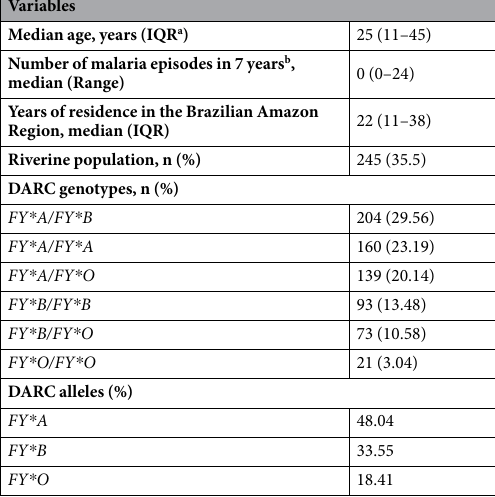
Table 1. Demographic, epidemiological and genetic data of 690 subjects from the Rio Pardo Settlement, Amazonas, Brazil. a IQR, interquartile range. b The number of malaria episodes was obtained from the